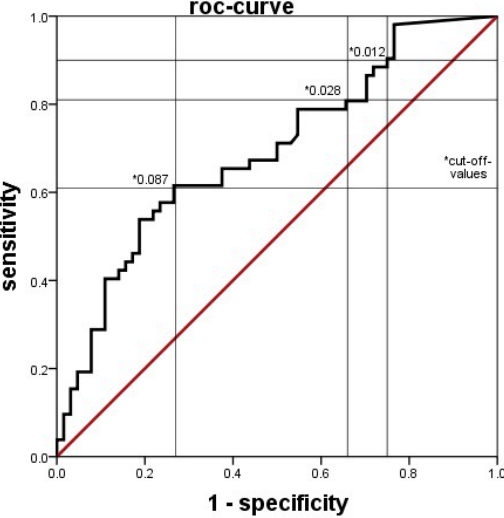
Figure 6. ROC-curve of the diagnostic accuracy of detecting a probable infection by the manually counted I/T-ratio. The area under the curve was 0.692. * Several different cut-off values with their respective sensitivity and specificity are indicated.